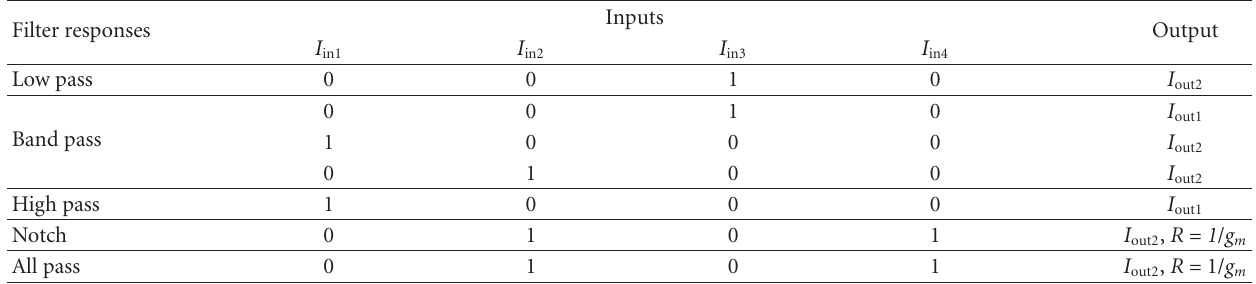
Table 4: The I in1 , I in2 , I in3 , and I in4 values selection for each filter function response. Filter responses